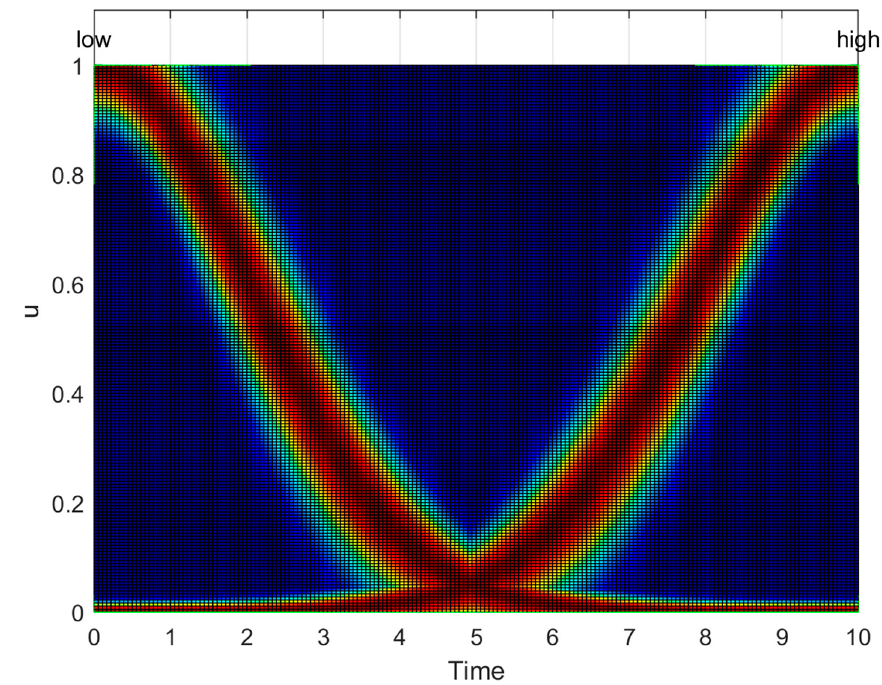
Figure 10. Input MFs of the time linguistic variable.